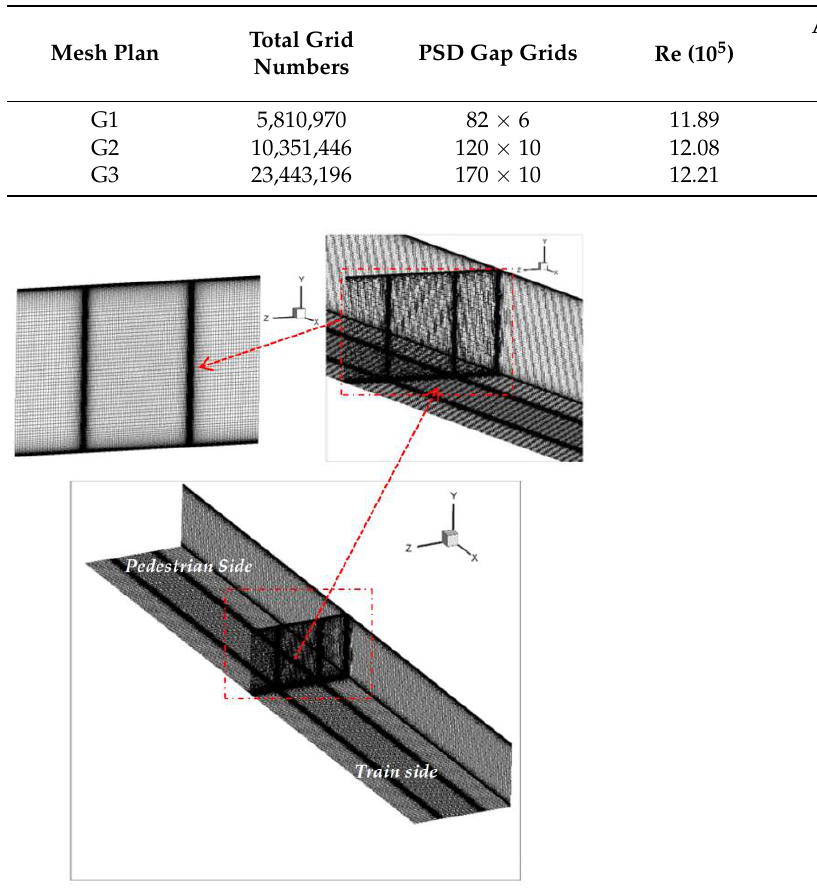
Table 2. Grid-independence tests summary.